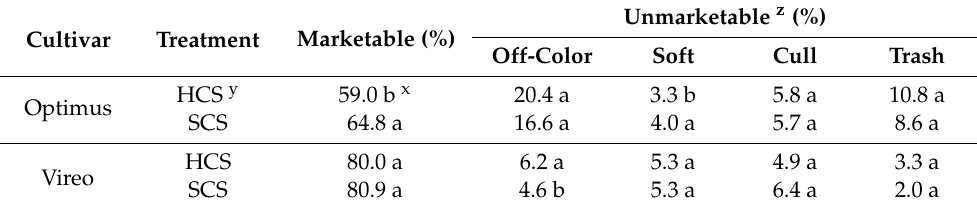
clamshell containers per cultivar). Table 2. Packout distribution of machine harvested blueberries of “Optimus” and “Vireo” with hard- or soft-catch surfaces at one day after harvest. All blueberries from Harvest 2 were forced-air cooled, held overnight at 10 ◦ C, and then commercially sorted.